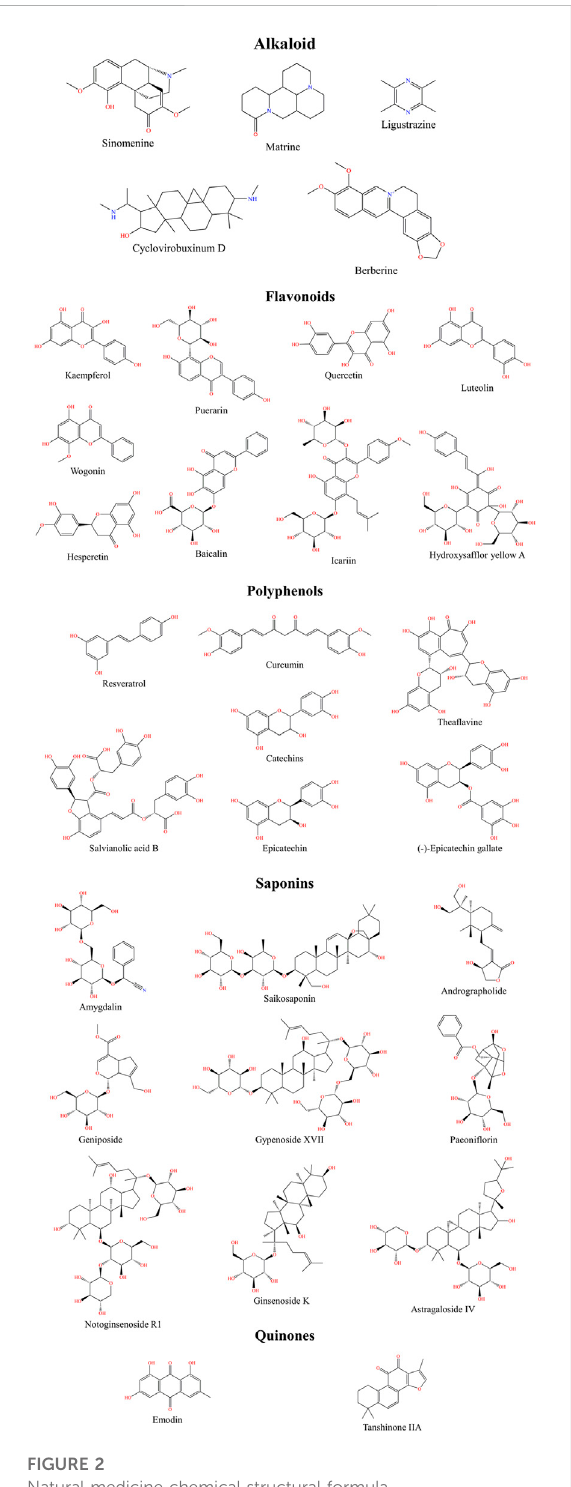
FIGURE 2 Natural medicine chemical structural